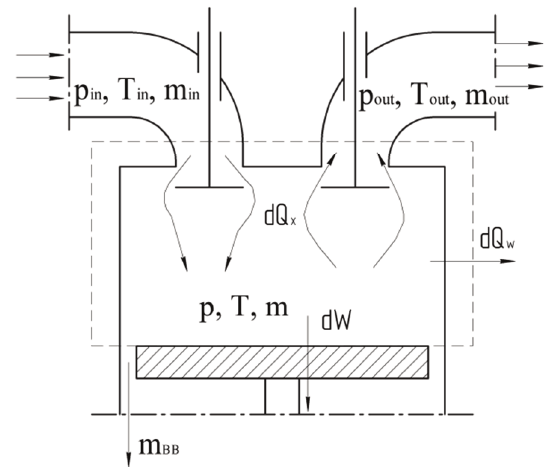
Fig. 2. Thermal balance of the single-zone model